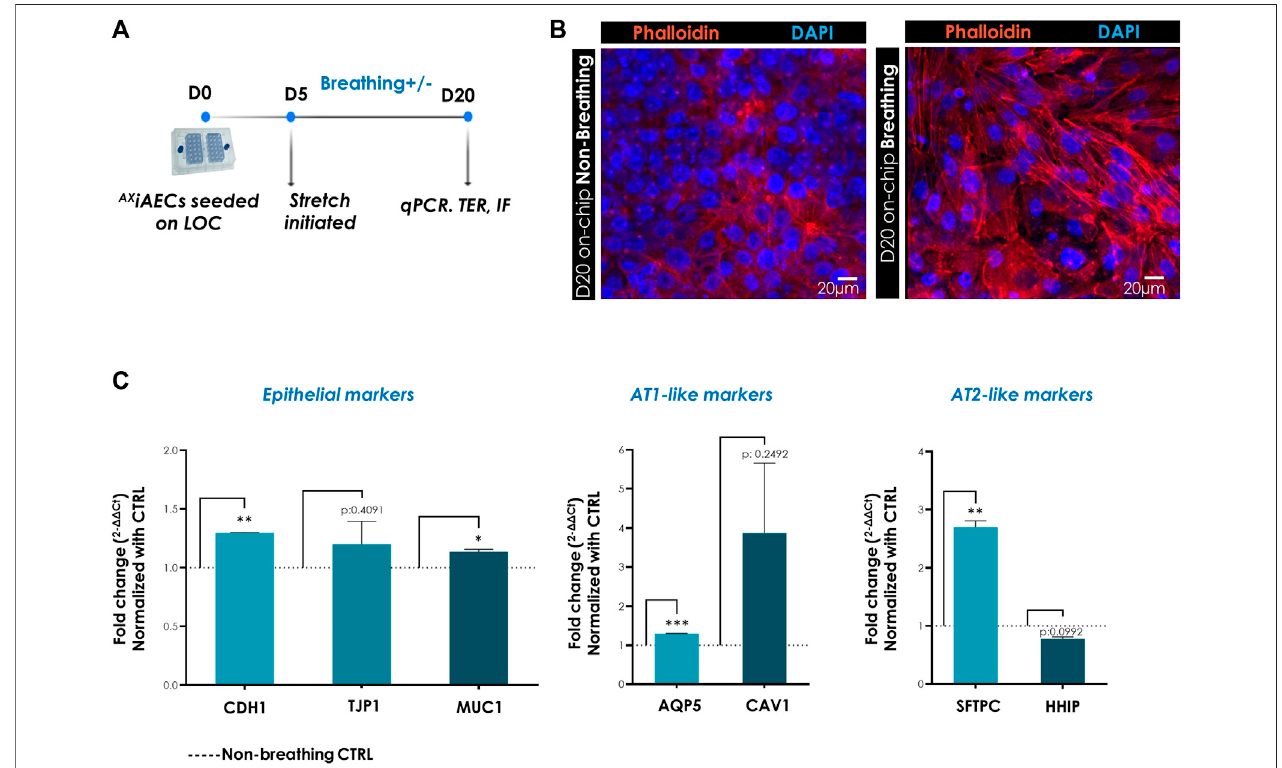
FIGURE 5 | Breathing-induced differential gene expression in AX iAECS on-chip. (A) Timeline and schematic of the AX iAECs cultured in the AX Lung-on-chip. BreathingwasstartedatD5on-chip. (B) Immuno fl uorescentstainings of AX iAECsinbreathingand non-breathing(CTRL)conditions, fi xedafter 20 daysculture onAX12 and stained with phalloidin to visualize F-actin fi bers (red). Nuclei were stained with DAPI (blue). Scale bar = 20 µm. (C) Normalized gene expression of epithelial cell associated,alveolartype Icellspeci fi cand alveolar typeIIcellspeci fi cmarkersfollowing20 days ofcultureinAX12.Datashown asmean±SEM(N=2; n =4), * p < 0.05, ** p < 0.01, *** p <